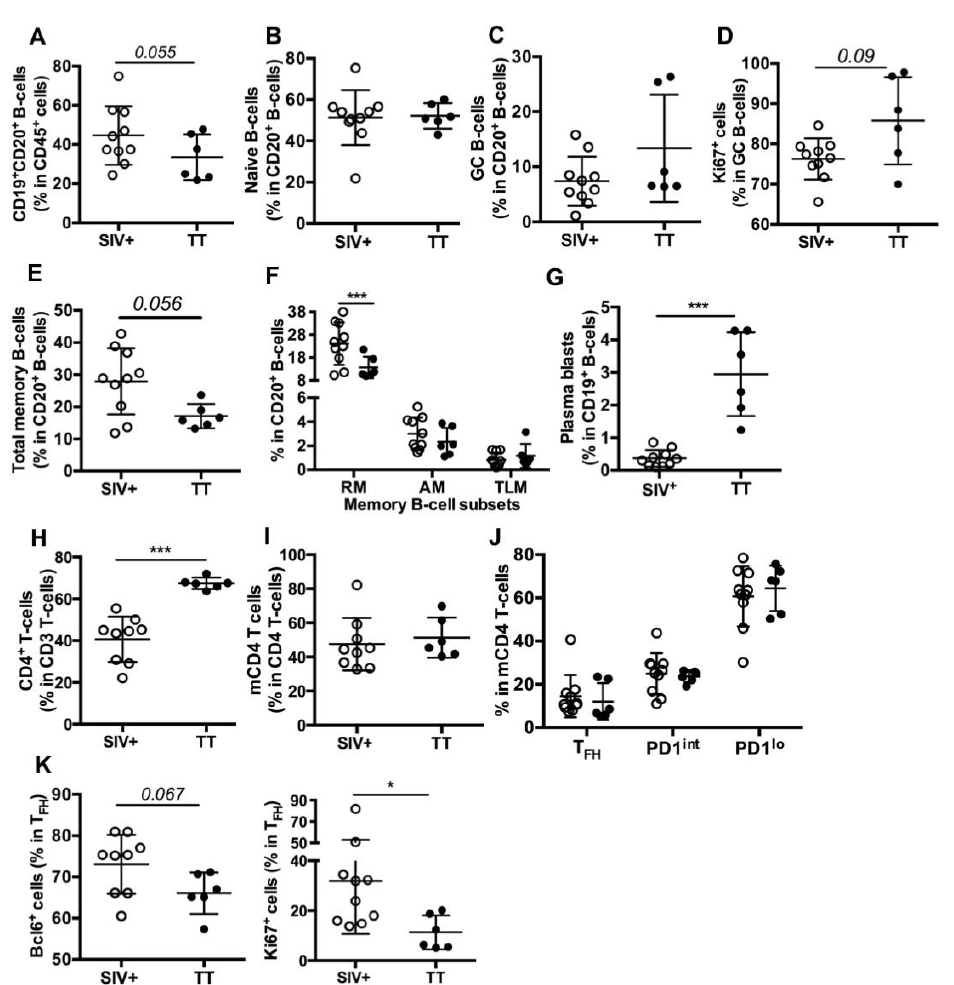
Figure 3. B- and T-cell subsets in inguinal LNs from SIV-infected and TT-vaccinated macaques. Cell proportions were determined by FCM for each macaque. Shown are proportions of ( A ) CD19 + CD20 + B-cells (thereafter referred to as CD20 + B-cells) in nodular CD45 + cells; ( B , C ) naïve and GC B-cells in CD20 + B-cells; ( D ) Ki67 + cells in GC B-cells; ( E , F ) Total memory, RM, AM and TLM B-cells in CD20 + B-cells; ( G ) plasma blasts in CD19 + B-cells; ( H ) CD4 + T-cells in CD3 + T-cells; ( I ) memory CD4 T-cells (mCD4 T-cells) in CD4 + T-cells; ( J ) T FH , PD1 int and PD1 lo subsets in mCD4 T-cells and (K ) Bcl-6 + and Ki67 + cells in T FH are shown. Each dot represents one macaque from the SIV + ( open circle ) or TT ( black circle ) group. Bars represent Mean ± SD. For all panels except ( F ) and ( J ), statistical comparison between groups was performed using the Mann Whitney non-parametric test. For ( F ) and ( J ) panels, statistical comparison was performed using 2-way ANOVA with Bonferroni’s multiple comparisons test. Statistically significant values are indicated: * p < 0.05 and *** p < 0.001 .